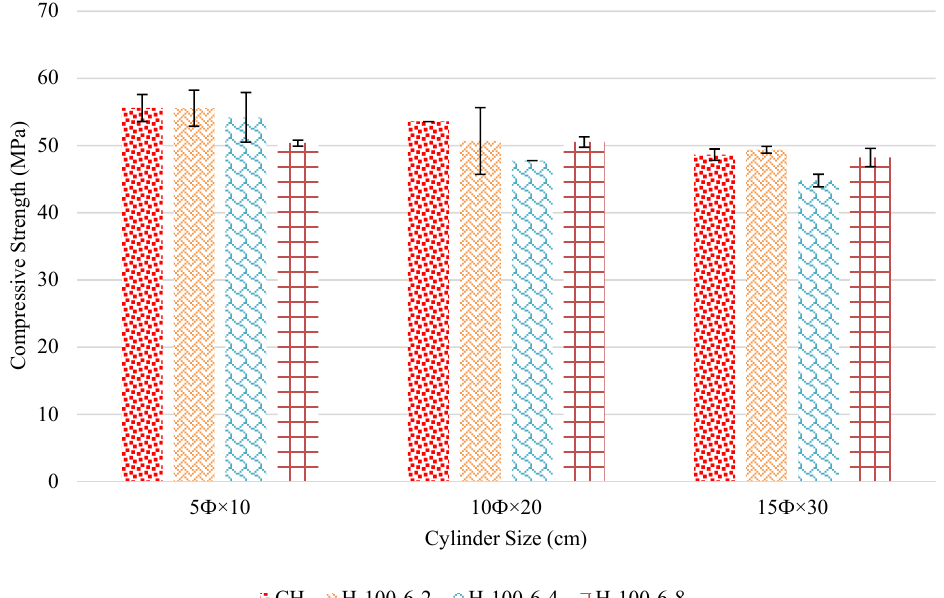
Figure 5. Result of 28-day high strength concrete of different size cylinders cured with 100% CO 2. Table 5. Strength and k s value from different size cylinders (unit:MPa).